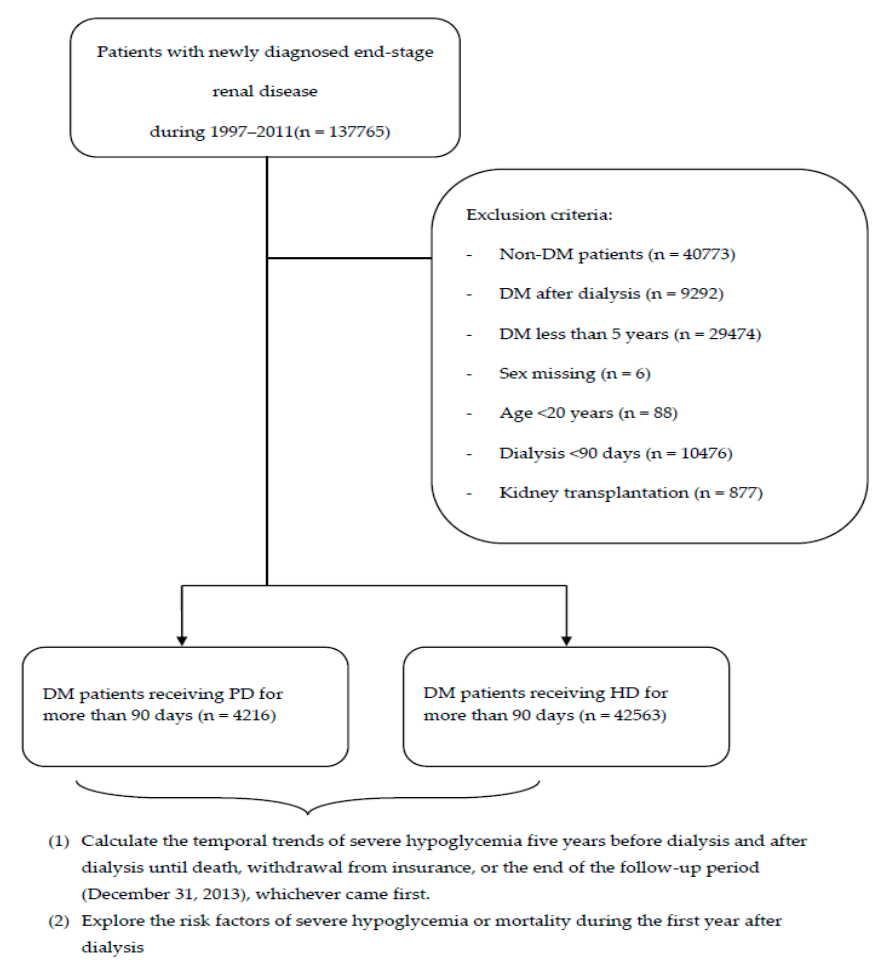
Figure 1. Flow chart demonstrating enrollemnt of the study cohort. (DM: diabetic mellitus; PD: peritoneal dialysis; HD: hemodialysis.)